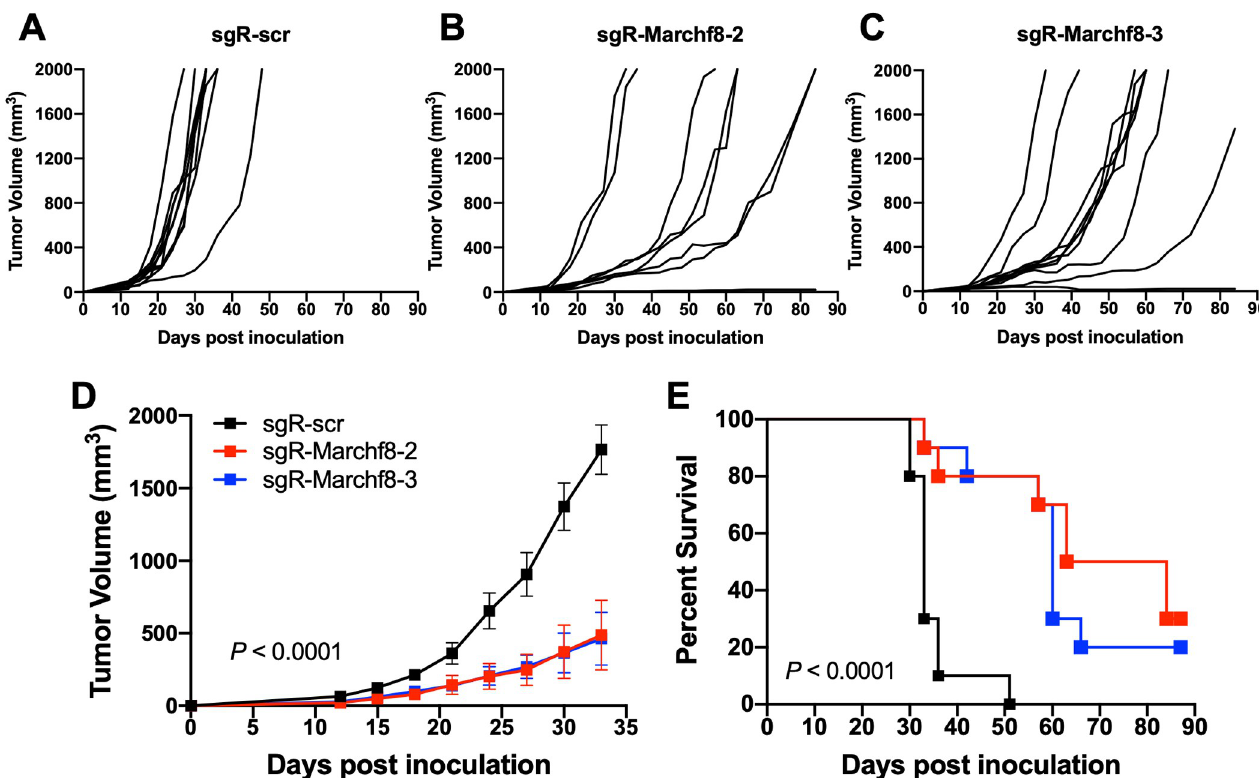
Fig 9. Knockout of Marchf8 expression suppresses HPV+ HNC tumor growth in vivo. Marchf8 -knockout mEERL cells (mEERL/ Marchf8 -/- ) were generated by lentiviral Cas9, and two sgRNAs targeting Marchf8 (sgR-Marchf8-2 and sgR-Marchf8-3) or scrambled sgRNA (sgR-scr). mEERL/scr ( A ) or mEERL/ Marchf8 -/- ( B and C ) cells were injected into the rear right flank of C57BL/6J mice ( n = 10 per group). Tumor volume was measured twice a week ( A - D ). Survival rates of mice were analyzed using a Kaplan-Meier estimator ( E ). The time to event was determined for each group, with the event defined as a tumor size larger than 2000 mm 3 . The data shown are means ± SD. P values of mice injected with mEERL/ Marchf8 -/- cells compared with mice injected with mEERL/ scr cells were determined for tumor growth ( D ) and survival ( E ) by two-way ANOVA analysis. Shown are representative of two independent